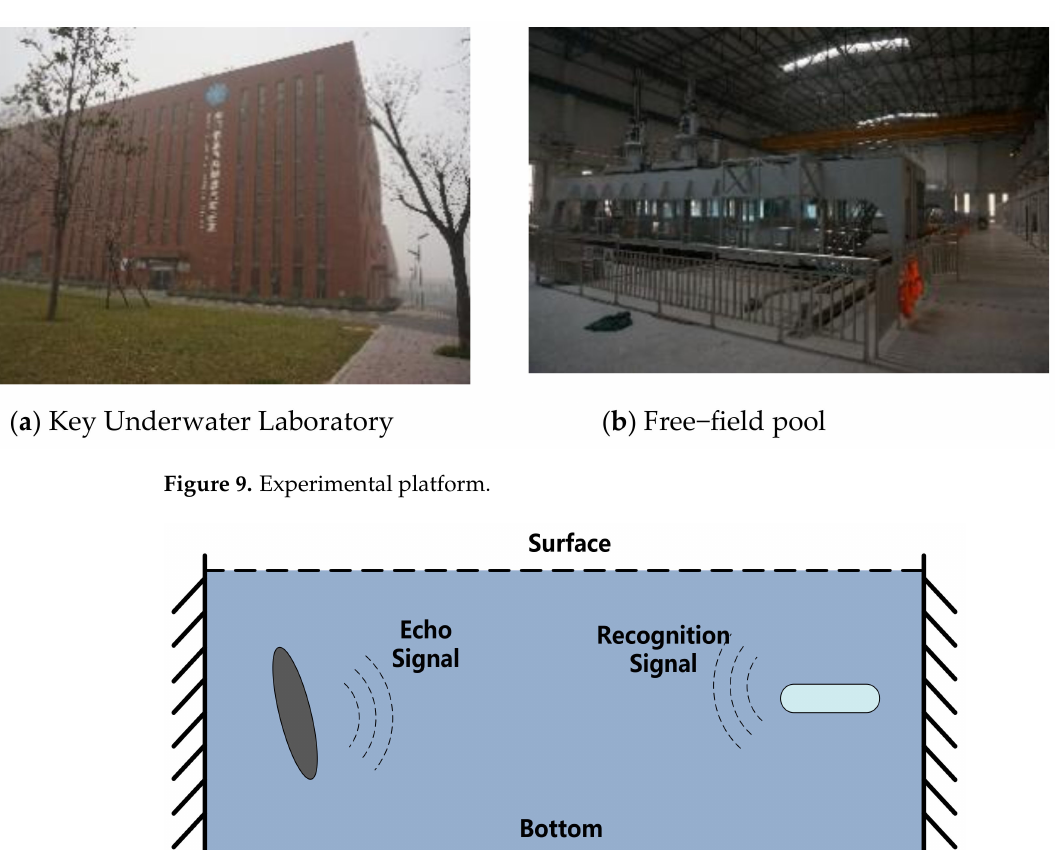
Figure 10. Side view of pool experiment.